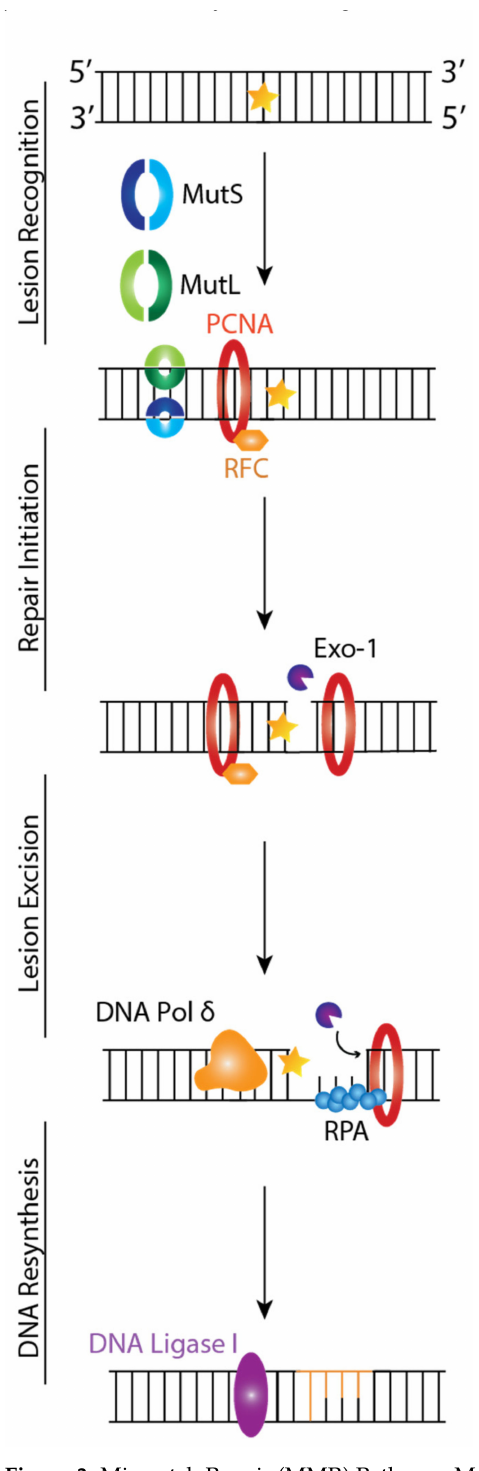
Figure 3. Mismatch Repair (MMR) Pathway. MutS and MutL start DNA repair by recognizing and binding to mismatches. PCNA and RFC will be recruited to the site of damage to initiate repair. These interactions will lead to the recruitment of Exo1 to a strand break where it will excise the damaged DNA from the nick up to and beyond the mismatch depending on the MutS, MutL, and RPA. During DNA resynthesis, DNA Pol δ will use the parental strand as a template to repair the mismatch, followed by DNA Lig I ligation. The orange star denotes DNA